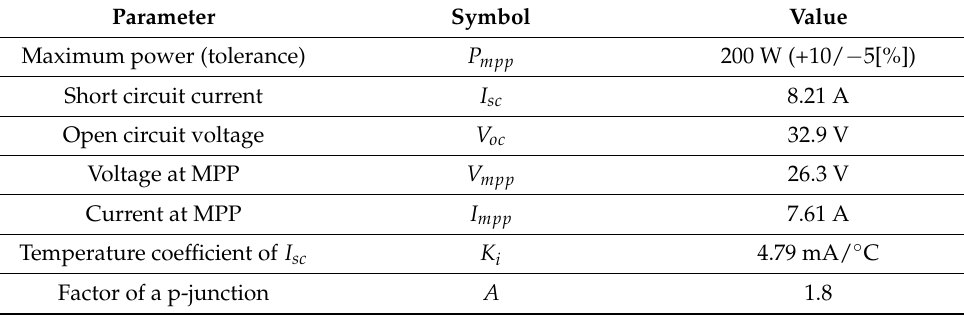
Table 3. Electrical Specifications of KC200GH-2P PV Module in Standard Conditions.